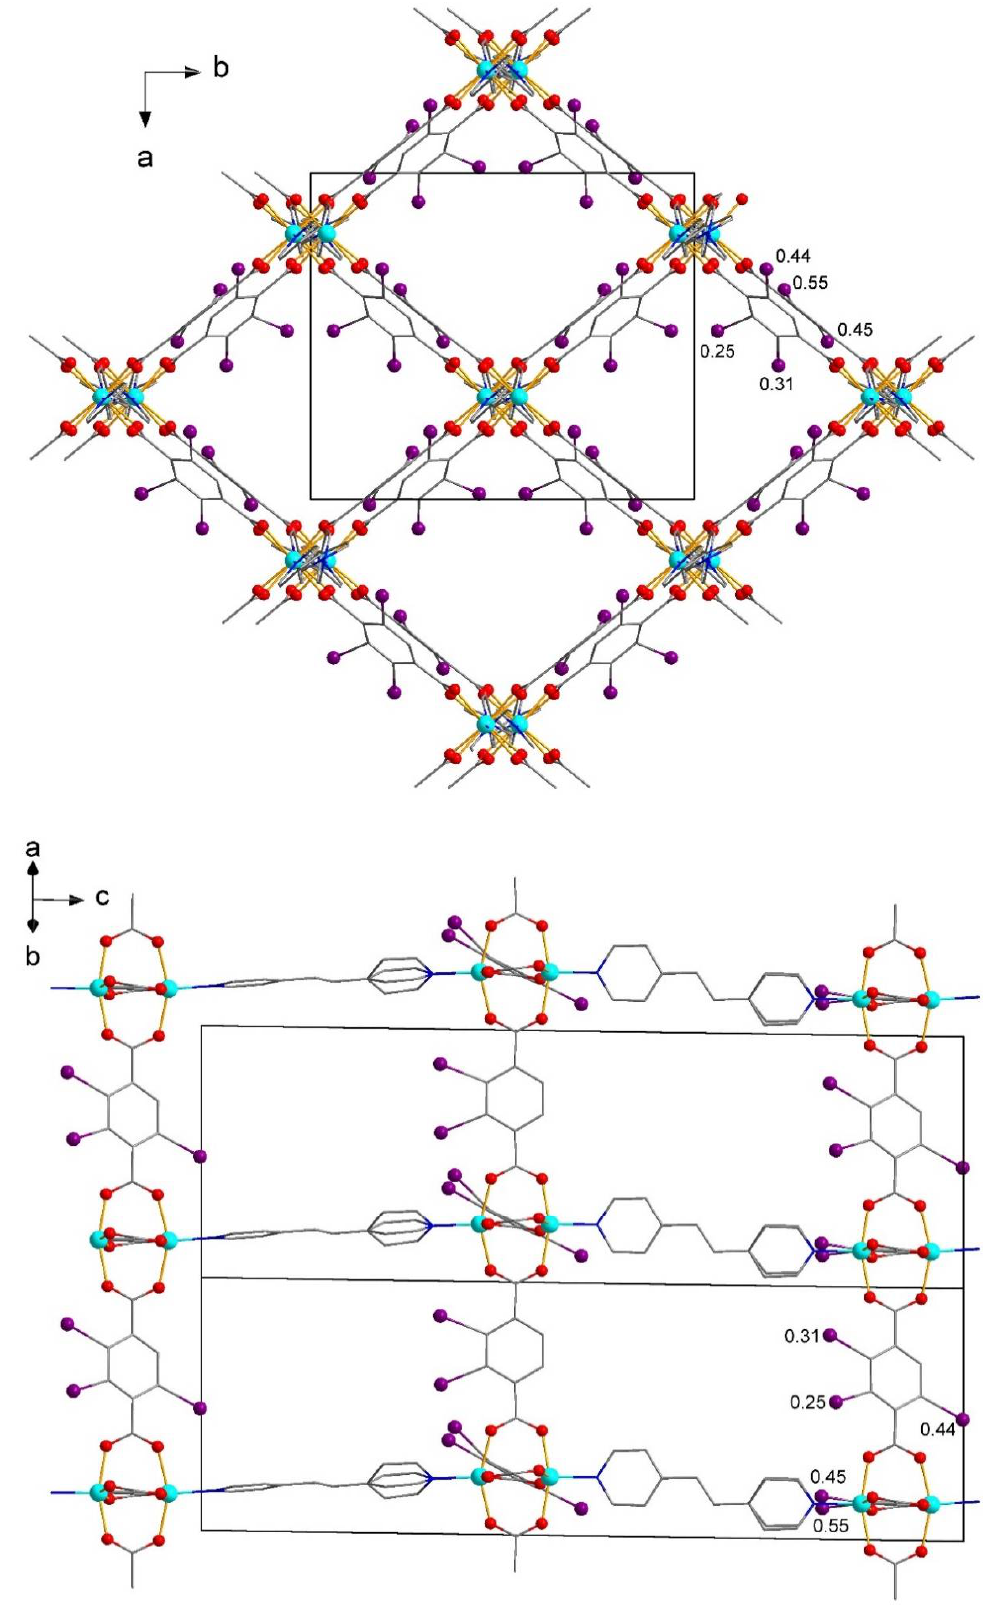
Figure 2. A fragment of the framework of 1 . Hydrogen atoms are omitted, the occupancy of disordered I atoms is shown.